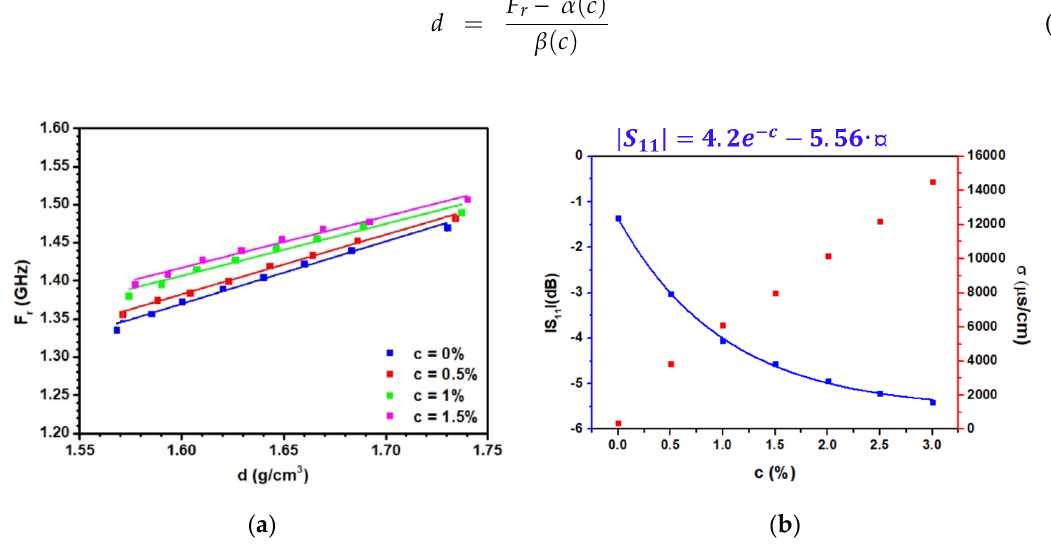
Figure 10. ( a ) The resonant frequency F r as a function of the density for several ionic concentrations c. ( b ) The S 11 reflection parameter measured at 0.5 GHz and the conductivity σ as a function of the concentration c of NaCl solutions.